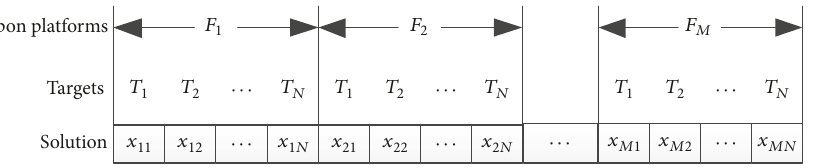
Figure 2: The decimal integer encoding method for position vectors